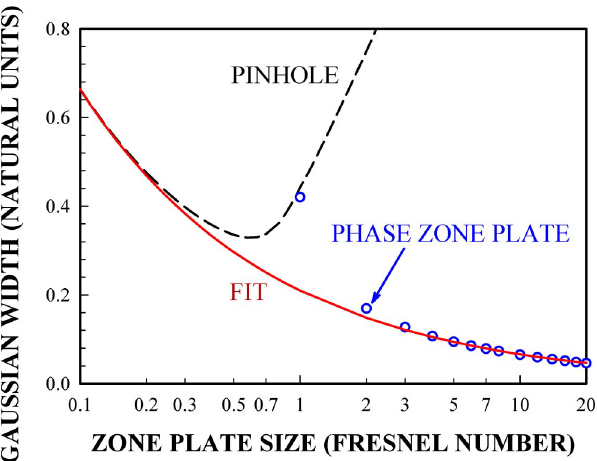
FIG. 10. (Color) Calculated Gaussian width of image profiles of a zone plate camera: (circle) phase zone plates, (dashed line) pinhole, and (solid line) fit for high Fresnel number cameras.